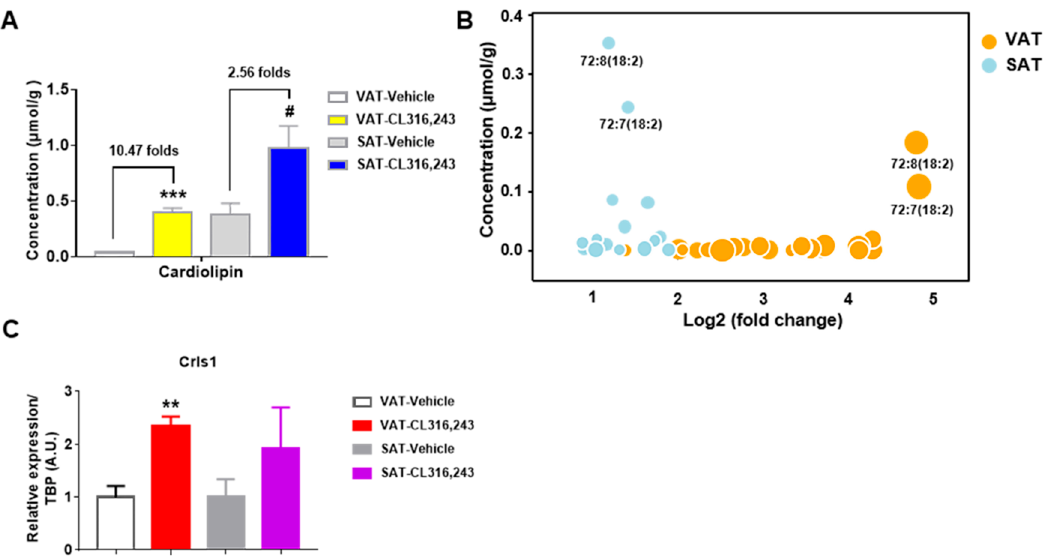
Figure 7. Cardiolipin was elevated by CL316,243 in both VAT and SAT. ( A ) The total content of cardiolipin was significantly altered in both VAT and SAT in response to CL316,243 treatment. In 35 species detected, ( B ) 27 molecular species were obviously changed in VAT, and 15 species were greatly altered in SAT. Dramatically changed particular species of cardiolipin are illustrated as circles. Size of circle indicates level of significance. All data are presented as mean ± SEM, n = 5. *** P < 0.001 compared with VAT Vehicle group. # P < 0.05 compared with SAT Vehicle group. ( C ) qPCR analysis of cardiolipin synthase 1 (Crls1) gene expression in VAT and SAT of mice injected with CL316,243. qPCR data are normalized to TBP and presented as mean ± SEM, n = 5. ** P < 0.01 compared with VAT Vehicle group. Table 1. Changes of cardiolipin species in VAT and SAT of mice under CL316,243 stimulation. VAT SAT Lipid Species Fold changes P value Fold changes P value